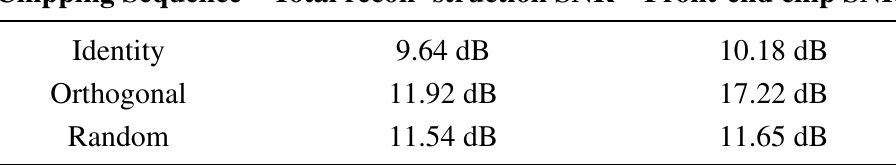
Table 2. 1 MHz Sine Wave